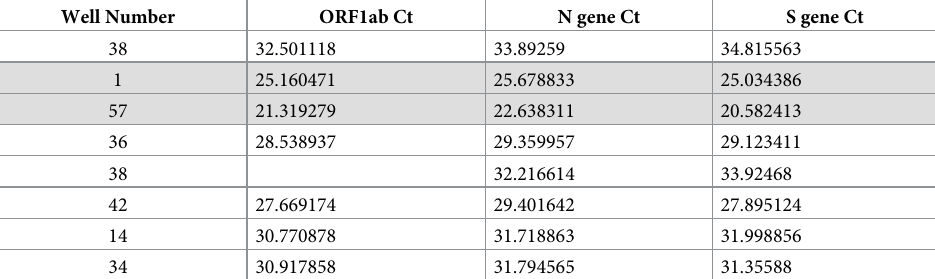
Table 2. Pillar 2 PCR Ct values of confirmatory samples positive for SARS-CoV-2. The samples which tested posi- tive on Lateral Flow device are in grey